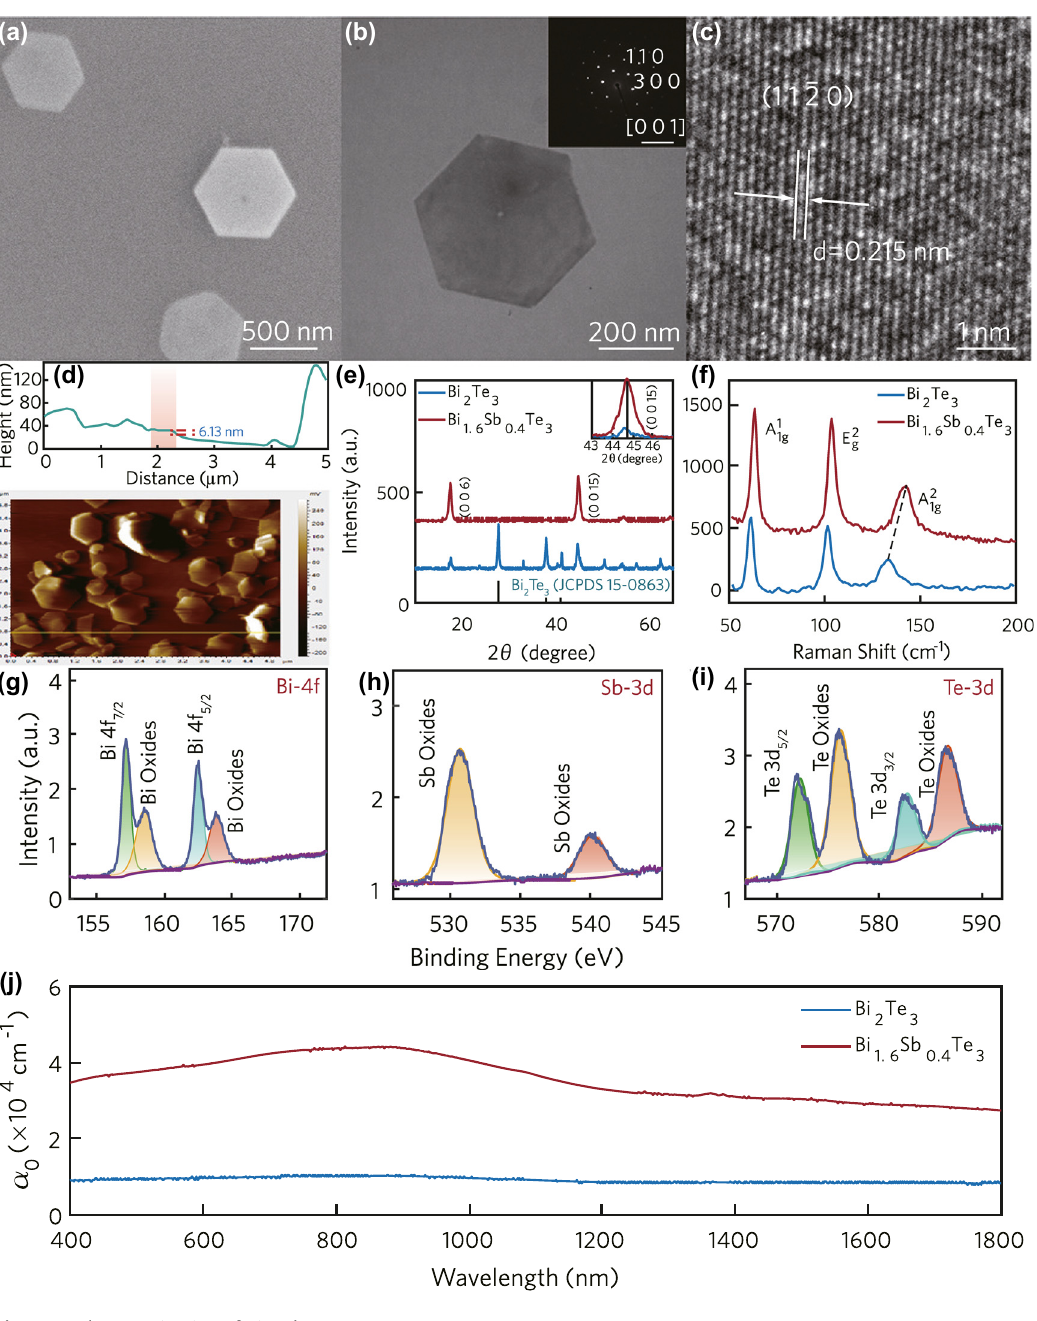
Figure 1: Characterization of Bi (a) SEM, (b) TEM (the inset is SAED pattern), (c) HRTEM, (d) AFM, (e) XRD patterns, and (f) Raman spectra; XPS spectra corresponding to the